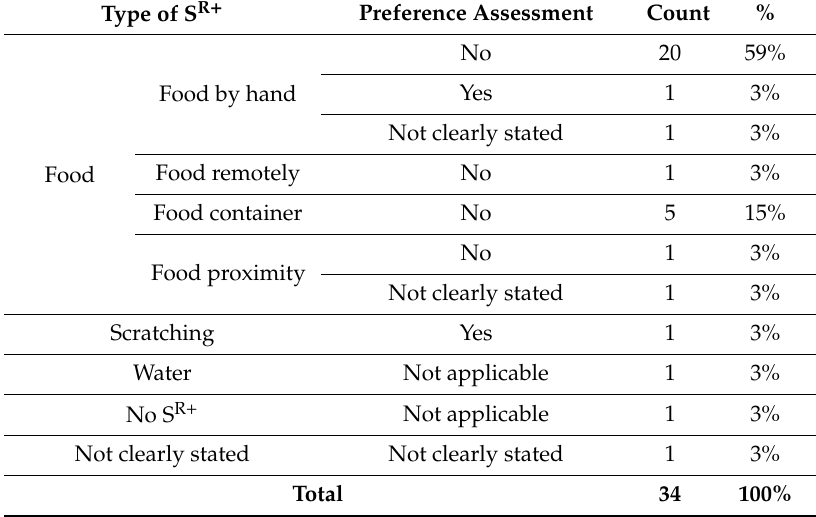
Table 4. Implementation of preference assessment displayed by type of unconditioned reinforcers (S R + ). Type of S R